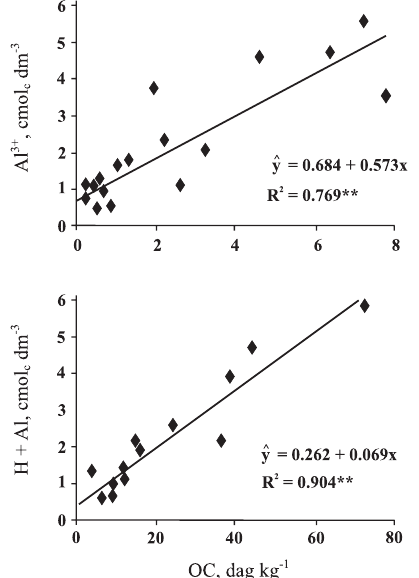
Figure 2. Relationship between organic C (OC) and exchangeable Al, and organic carbon and H+ Al horizons Spodic